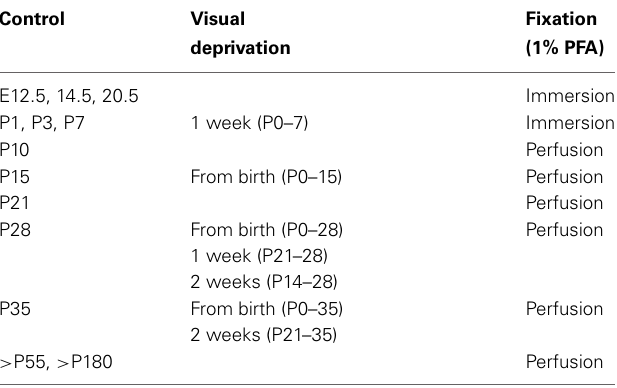
treatment of tissue for